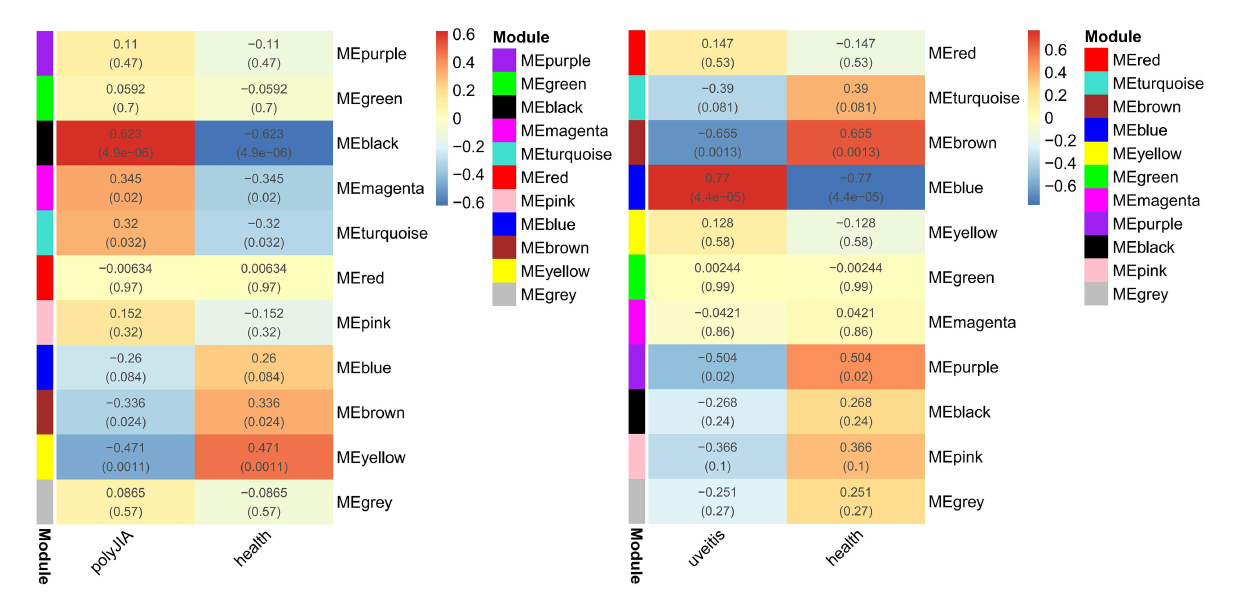
FIGURE 3 Weighted gene co-expression network analyses concerning immune-related genes associated with pJIA and uveitis. r value (P value); ME, module